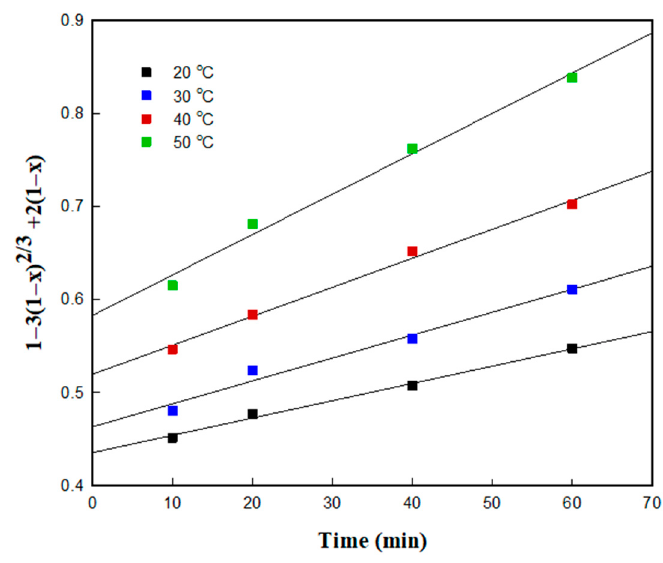
Metals 2020 , 10 , 293 Figure 9. Plot of (cid:4670) 1  3(1  x )